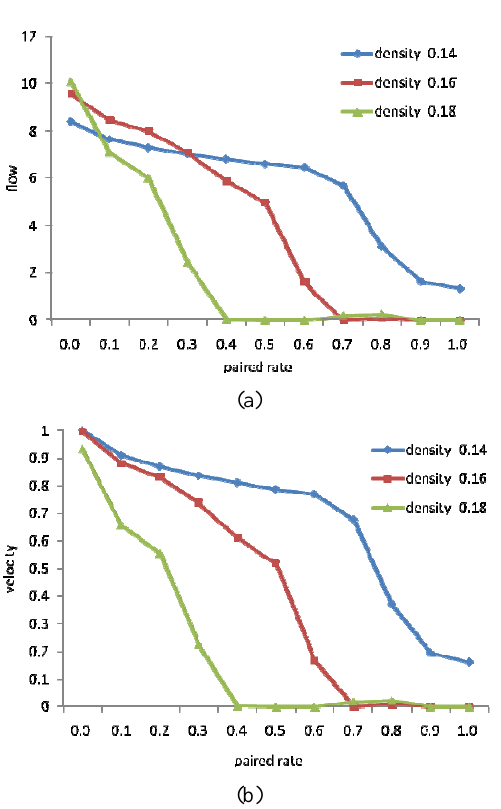
Fig. 6. The flow rate <f> and velocity <v> against paired rates with larger density gaps